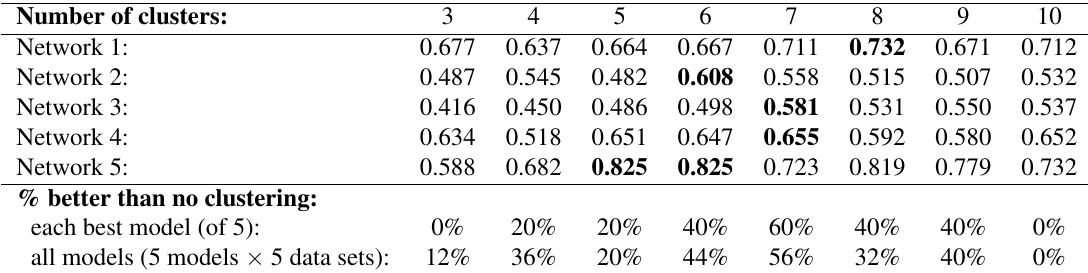
Table 1: Size 10 network AUROC scores. For each of 5 simulated data sets, the table shows the AU- ROC from the highest-likelihood inferred network (of 5) from each of a range of cluster numbers. The best score for each network is shown in bold. The bottom two rows give (1) the percentage of data sets for which the best model for the particular number of clusters out-performed the best no-clustering ( i.e. 10 cluster) model, and (2) the percentage of the all models fit for the particular number of clusters that out-performed the best no-clustering model.